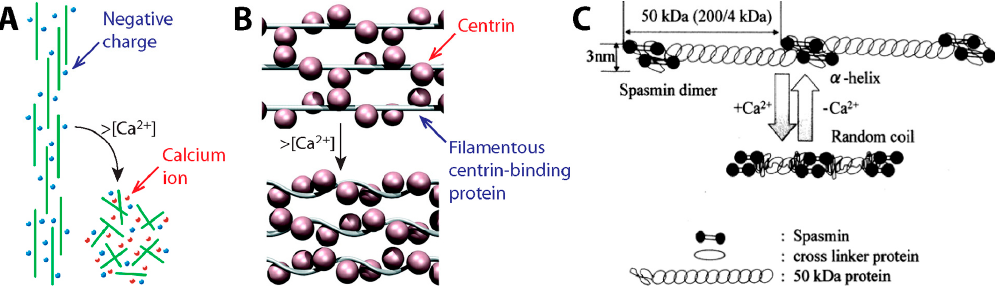
Figure 9. Suggested models for the Vorticella spasmoneme. ( A ) Electrostatic model based on the concept of the entropic spring (reproduced from [15]); ( B ) two-component model suggested for the centrin-based infraciliary lattice of Paramecium (reproduced from [107]); ( C ) two-component model considering the protein components (spasmin and spaconnectin) of the spasmoneme (reproduced from [58]).